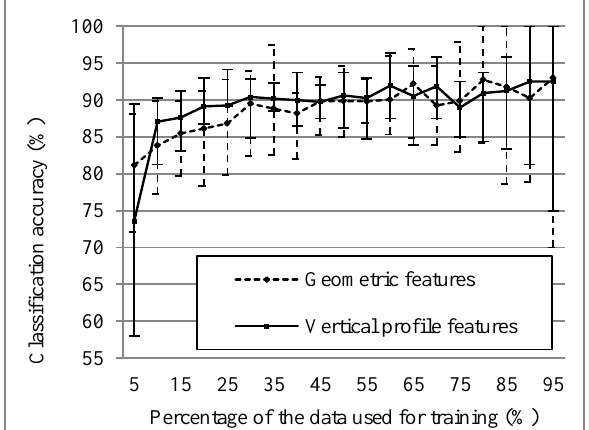
Figure 2. The average change in classification accuracy with increasing percentage of the data used for constructing classification trees, upper bars and lower bars represents the maximum and minimum accuracy respectively